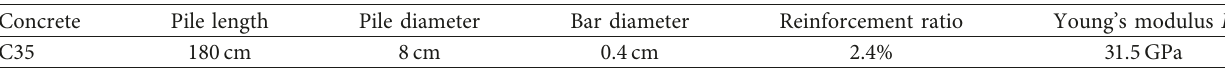
Figure 4: Cross section of the physical model and location of installed instruments. Table 2: Parameters of model